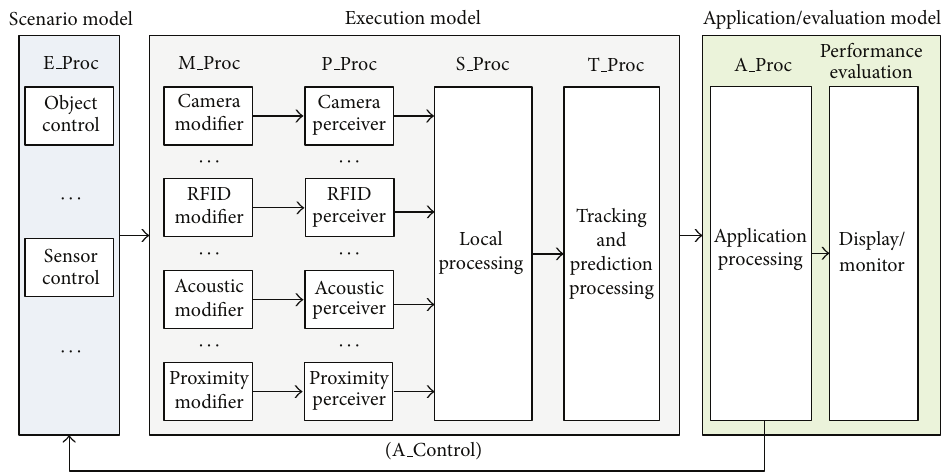
Figure 7: The overall structure of execution model interacting with environment model and application model.